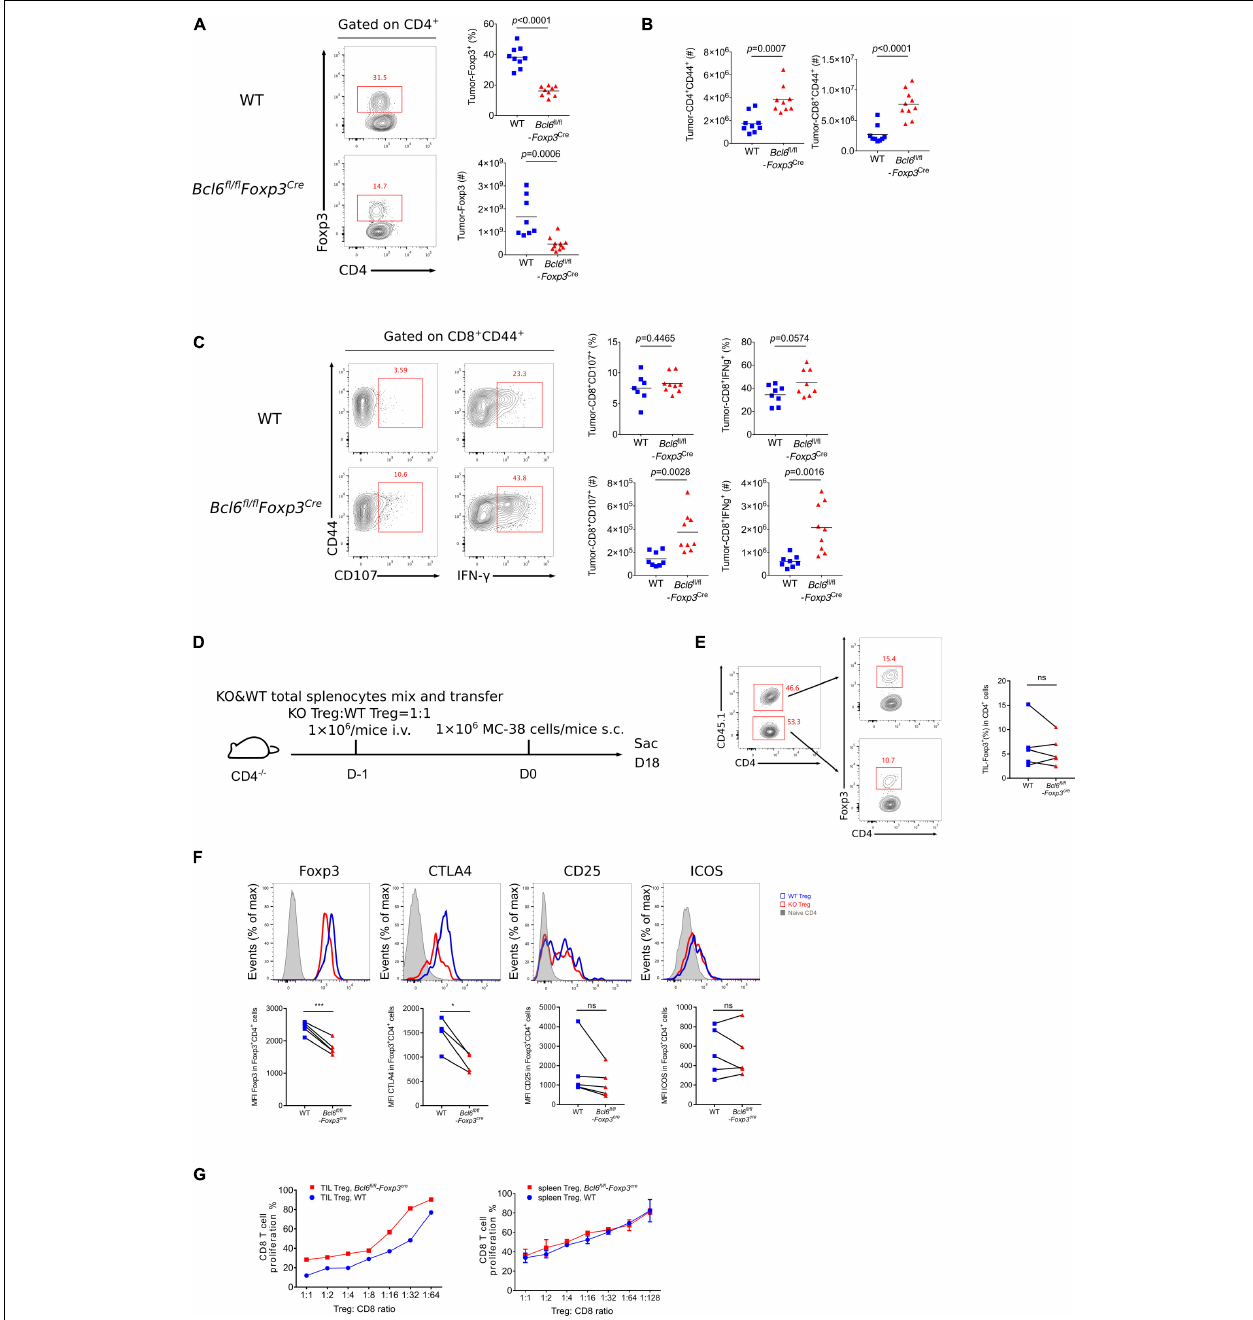
FIGURE 2 | The deficiency of Bcl6 impaired the suppressive capacity of Treg cells in TME. (A–C) Flow cytometry analysis, assessed at day 16 after MC-38 inoculation subcutaneously. The proportion and total number of Treg cells (A) and cytokine producing CD8 subsets (C) . Summary of the total number of CD4 + CD44 + and CD8 + CD44 + T cells (B) . The data (A–C) presented are representative of two independent experiments with 8–14 mice per group. # represents the absolute number and % represents the proportion of indicating population. Data are presented as mean ± SEM. Unpaired t -test. (D) Set up of splenic chimera mice, in situ model. Lymphocytes from WT and Bcl6 fl / fl Foxp3 Cre mice were collected, mixed and transferred 1 × 10 6 cells per mice to CD4 − / − recipients (Treg cells in a ratio of 1:1). On the following day, 1 × 10 6 MC-38 cells were injected subcutaneously into recipient mice and mice were sacrificed at day 18 post tumor inoculation. (E,F) Flow cytometry of splenic chimera mice assay, analyzing the ratio of total CD4 + T cells in KO versus WT mice, Treg cell proportion in CD4 + T cells (E) , expression level of Foxp3, CTLA4, CD25 and ICOS in Treg cells (F) . The data presented are representative of two independent experiments with at least 4 mice per group. Paired t -test. * p < 0.05, *** p < 0.001, ns, no significant. (G) In vitro suppression assay. CD8 + T cell proliferation were assessed after incubated with tumor infiltrating Treg cells (CD4 + CD25 + GITR + , left) or naive spleen Treg cells (CD4 + CD25 + GITR + , right) sorted from Bcl6 fl / fl Foxp3 Cre or WT mice in the ratio of 1:1 to 1:64 for 72 h. See also Supplementary Figures 1 , 2